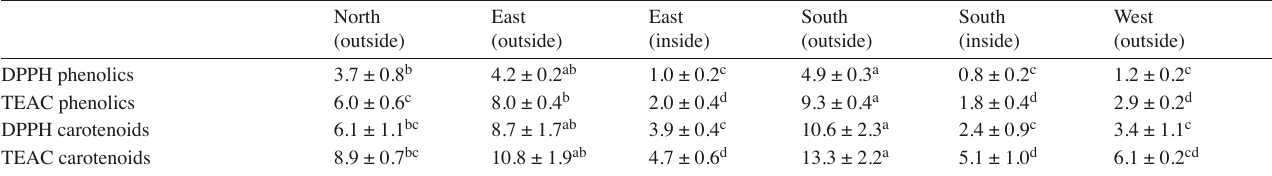
Tab. 6: Antioxidant activity in phenolic and carotenoid extracts [mmol Trolox equivalent * 100 g -1 FW] in kale samples harvested after 7 weeks of growth under urban Different letters indicate significant differences of means according to Tukey’s test ( p ≤